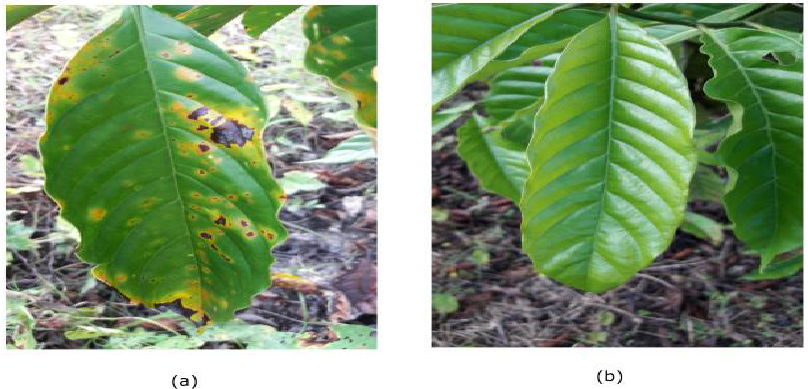
Figure 3. Robusta coffee leaf images dataset. ( a ) non-healthy image; ( b ) healthy image.